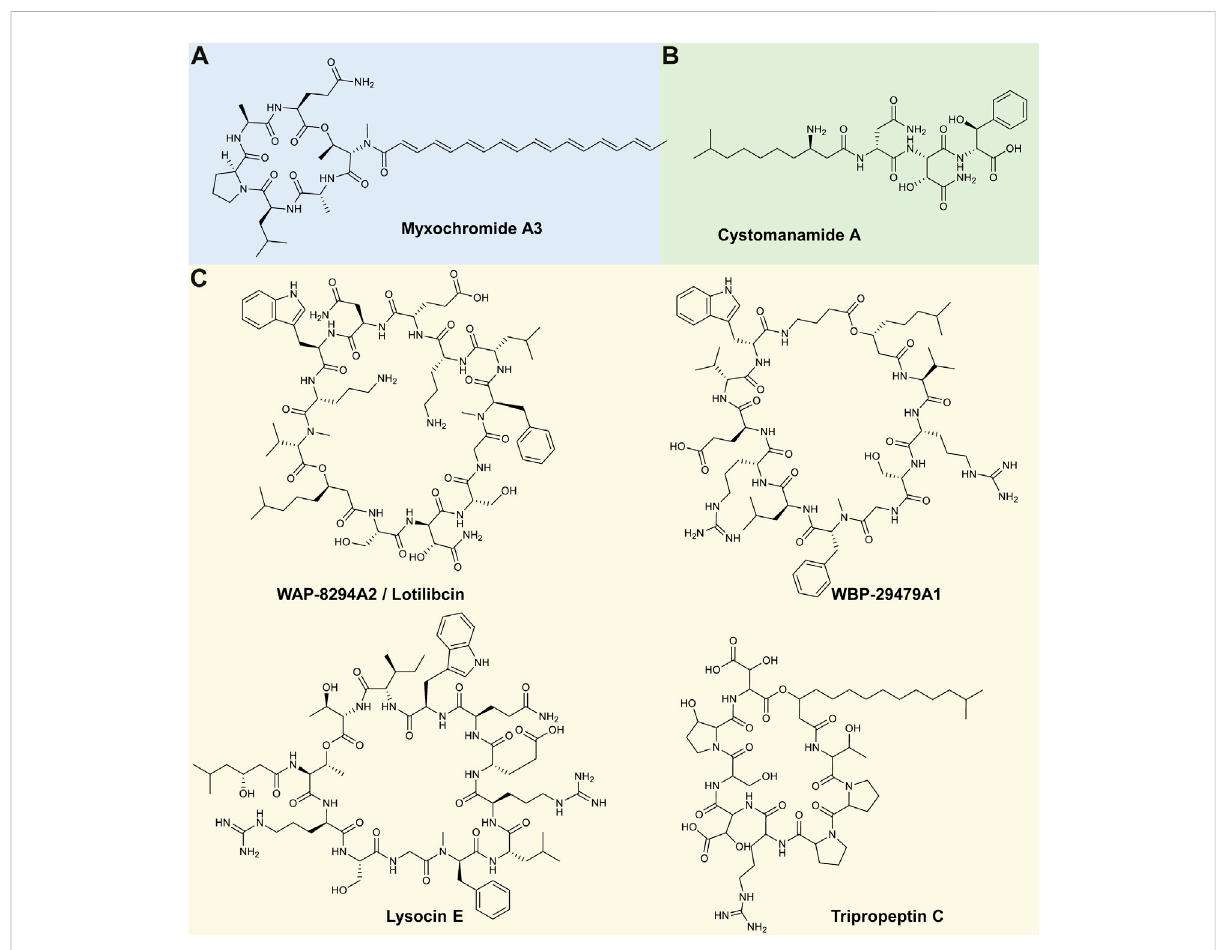
FIGURE 3 Representative lipopeptides produced by (A) Myxococcus species, (B) Cystobacter species and (C) Lysobacter species. The structural information was obtained from the PubChem database (https://pubchem.ncbi.nlm.nih.gov/), as well as the corresponding references provided in- text. The structures were subsequently drawn in ChemDraw Ultra version